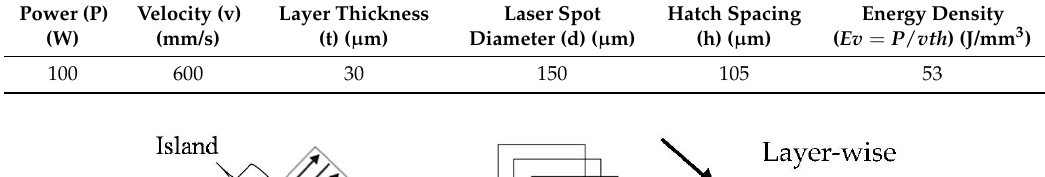
Table 2. Printing process parameters.